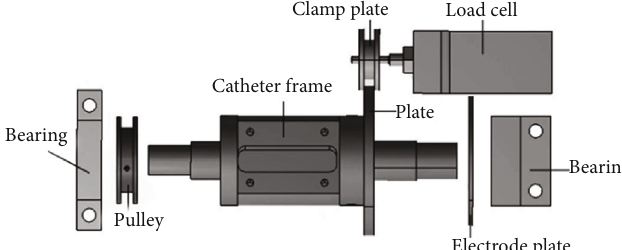
Figure 4: Axial force measurement mechanism.